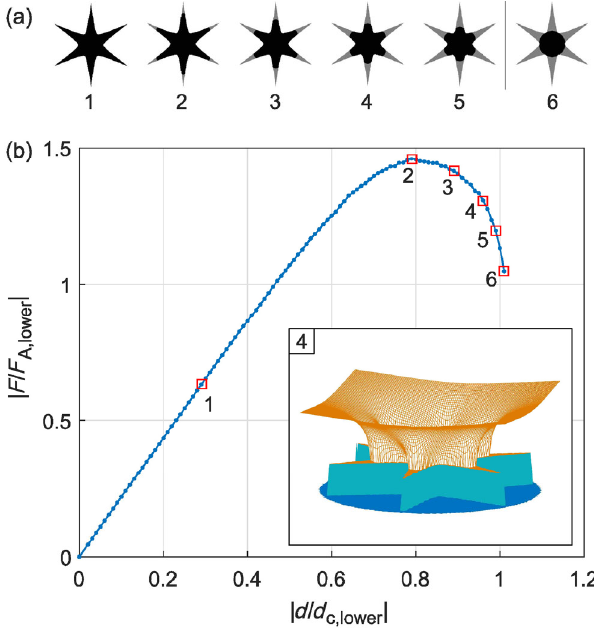
Fig. 5 Detachment process of a flat-ended indenter with the cross- section in form of a “star”. (a) A series of contact configurations: grey color shows the initial shape of the indenter and black color the remaining contact area. The detachment starts at the pointed ends of the star and spreads inwards up to a state which is close to the incircle of the shape. (b) Dependence of the absolute value of the normal force on the approach. The force is normalized to the low bound value (18) and the approach to the corresponding value (19). Subplot of (b): Three-dimensional “snap-shot” of the surface of the elastic half-space at a moment of partial